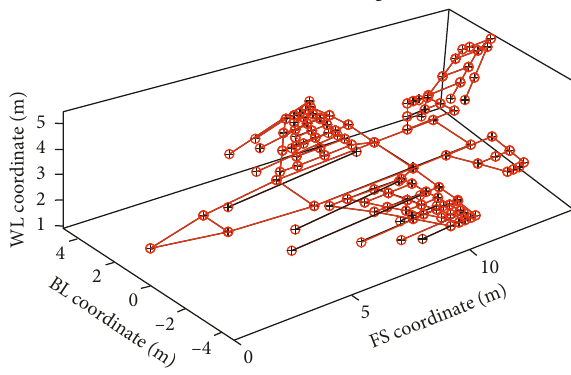
Figure 28: Mode shape for configuration 3 mode-1.